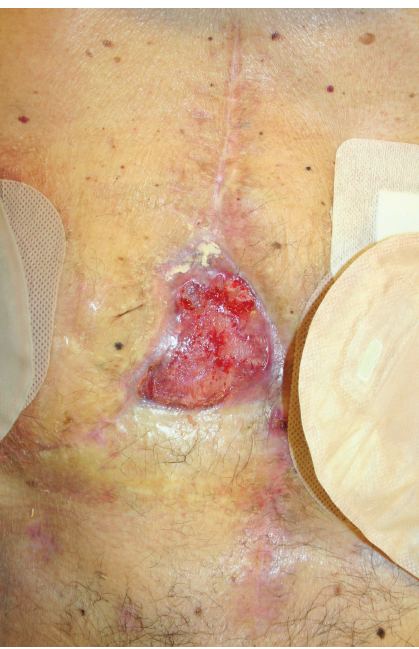
Figure 4: The final abdominal dehiscence after 43 days of